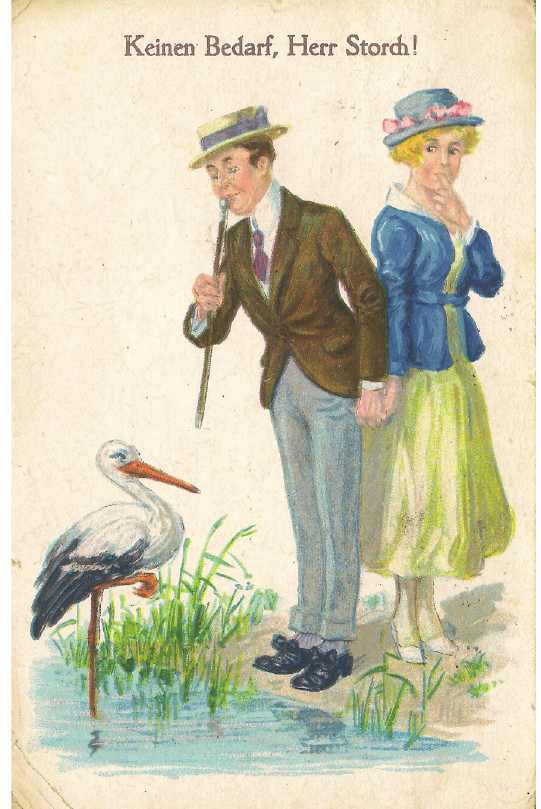
Figure 1. Postcard, circulated 1922. Private